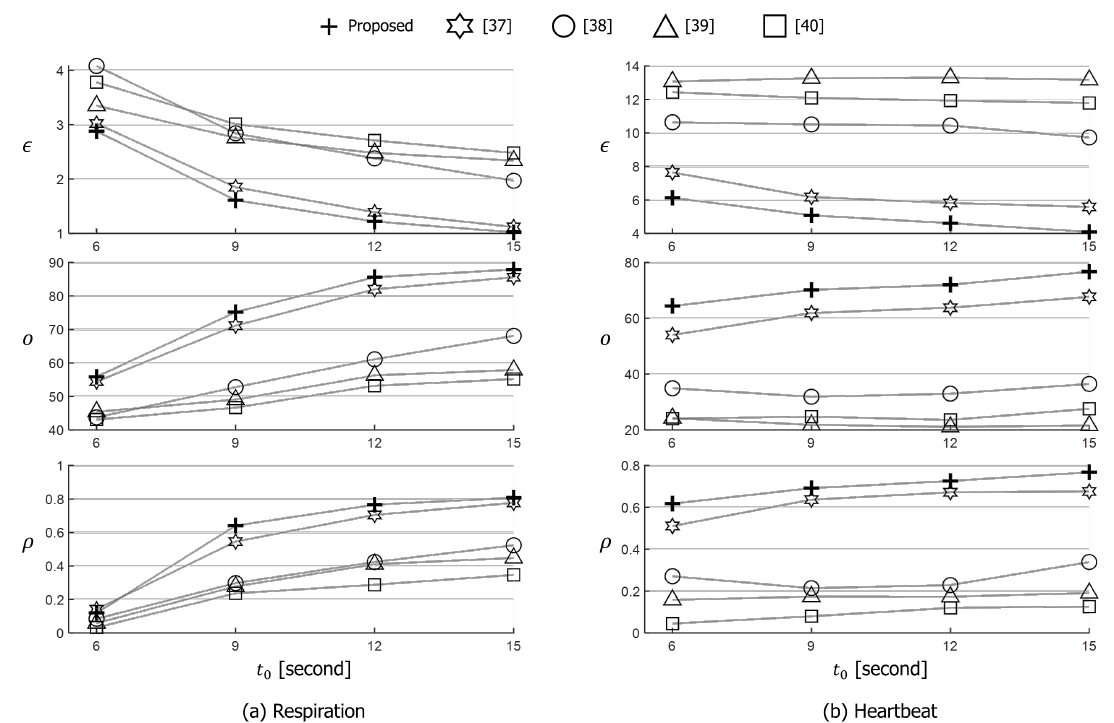
Figure 9. Extracted vital rates for various time window, t 0 . ( a ) Respiration rate, and ( b ) heart